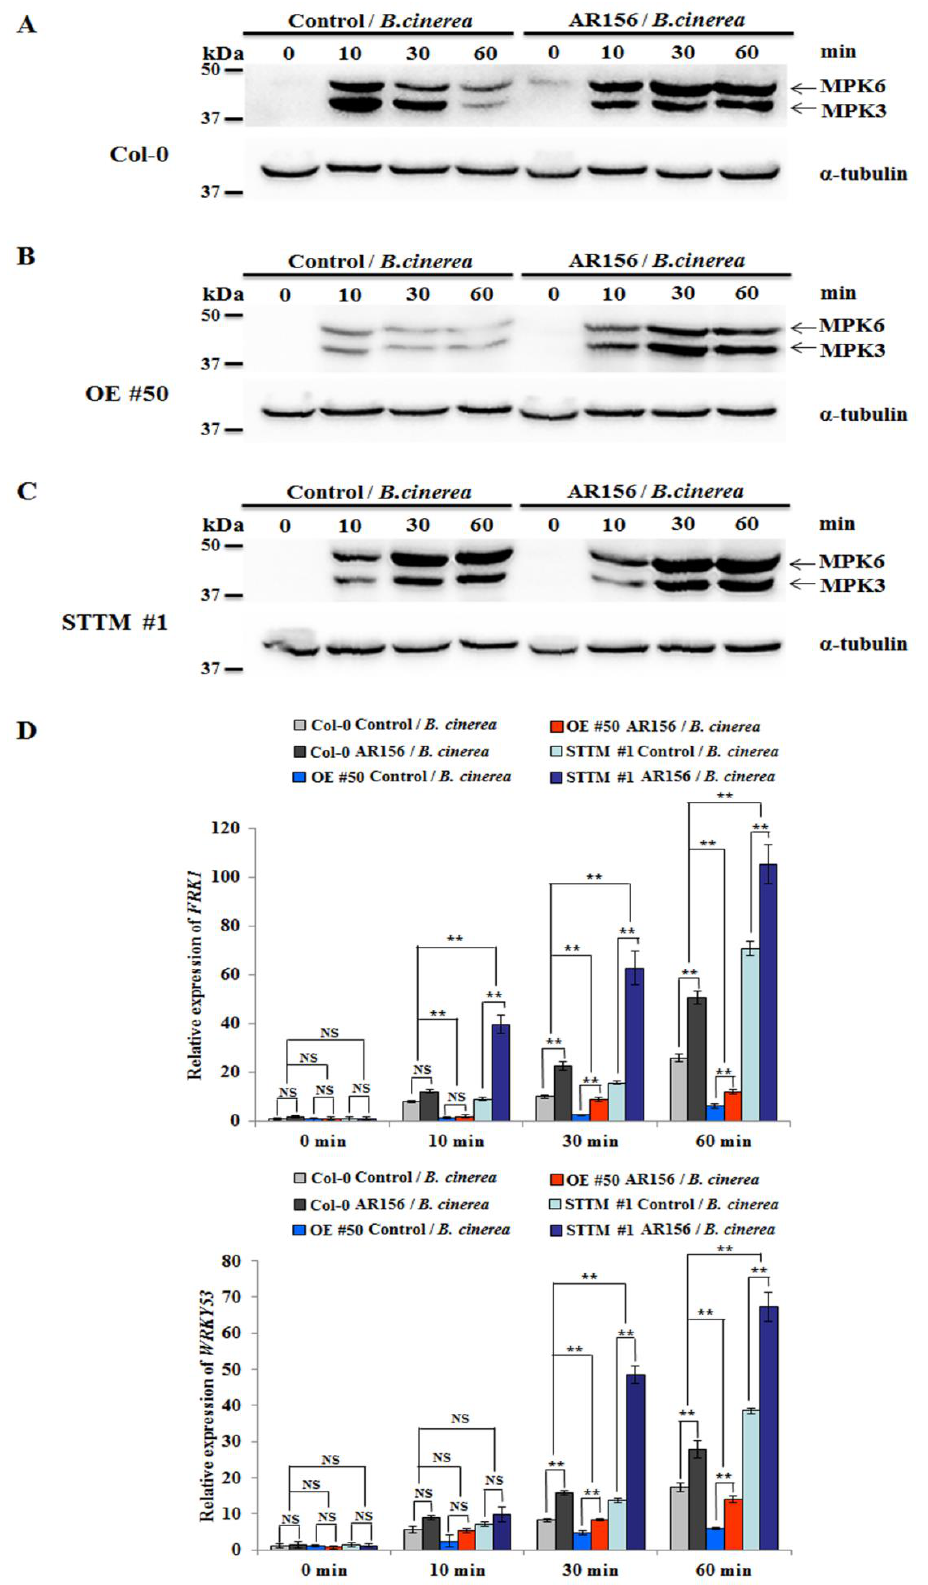
Figure 4. The role of miR825 and miR825* in AR156-triggered ISR and PTI. Three-week-old Arabidopsis plants from Col-0, miR825/825* OE line (#50), and STTM825/825* transgenic lines (#1) were pretreated with AR156 at 5 × 10 8 CFU/mL or 0.85% NaCl (the control) as a root drench. At 7 dpt, they were